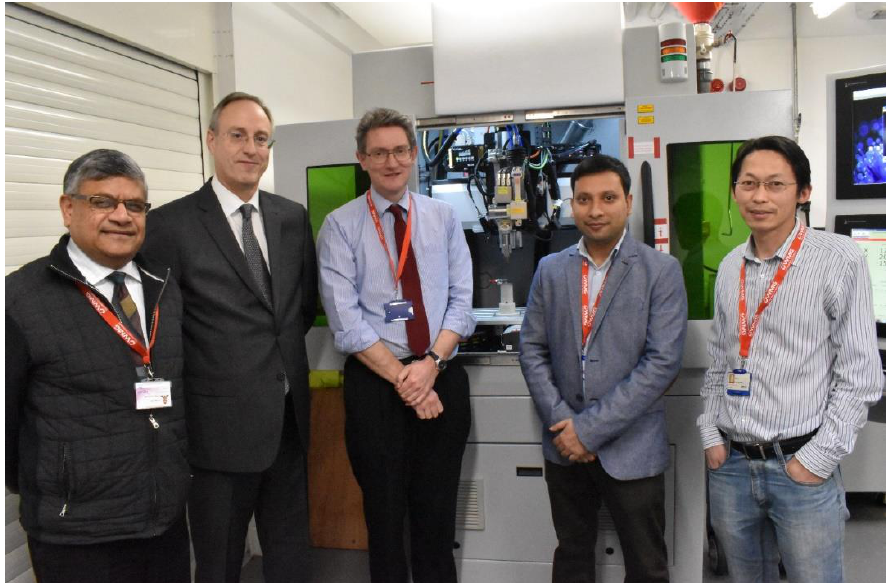
Figure 1. Our Cell engineering joining team group photo: From left – Anil Kumar Mistry (Principal Engineer); Dave Williams (Head of Programme Delivery), Iain Masters (Senior Research Fellow), Abhishek Das (Senior Research Fellow), and Dezhi Li (Senior Research Fellow).